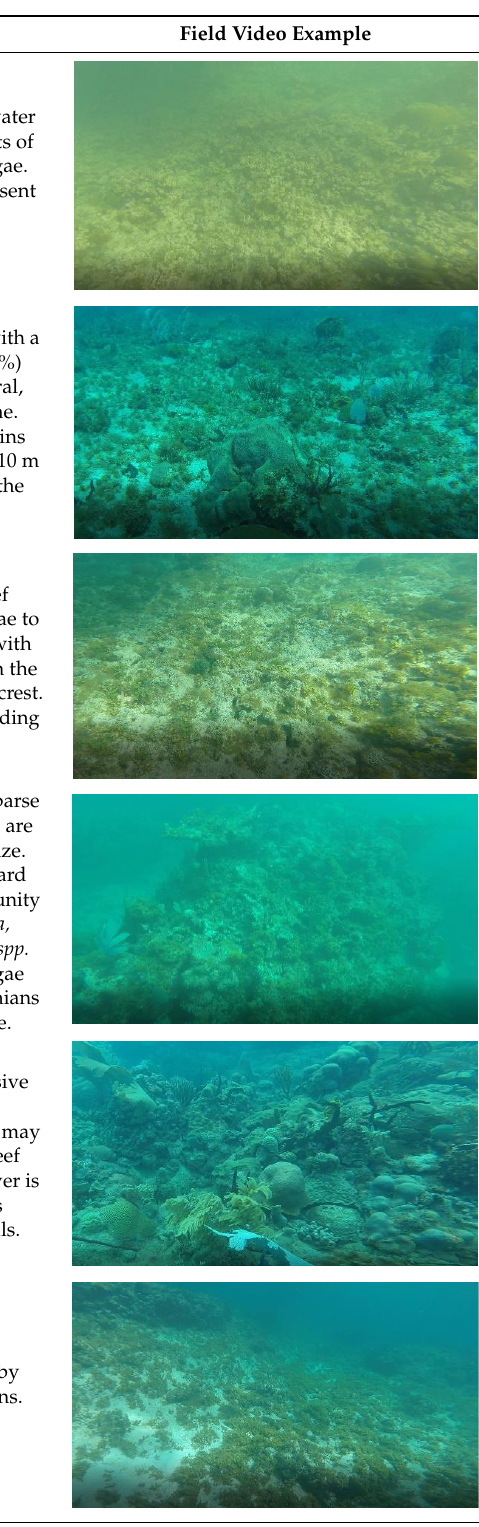
Table 1. Benthic composition classification scheme.